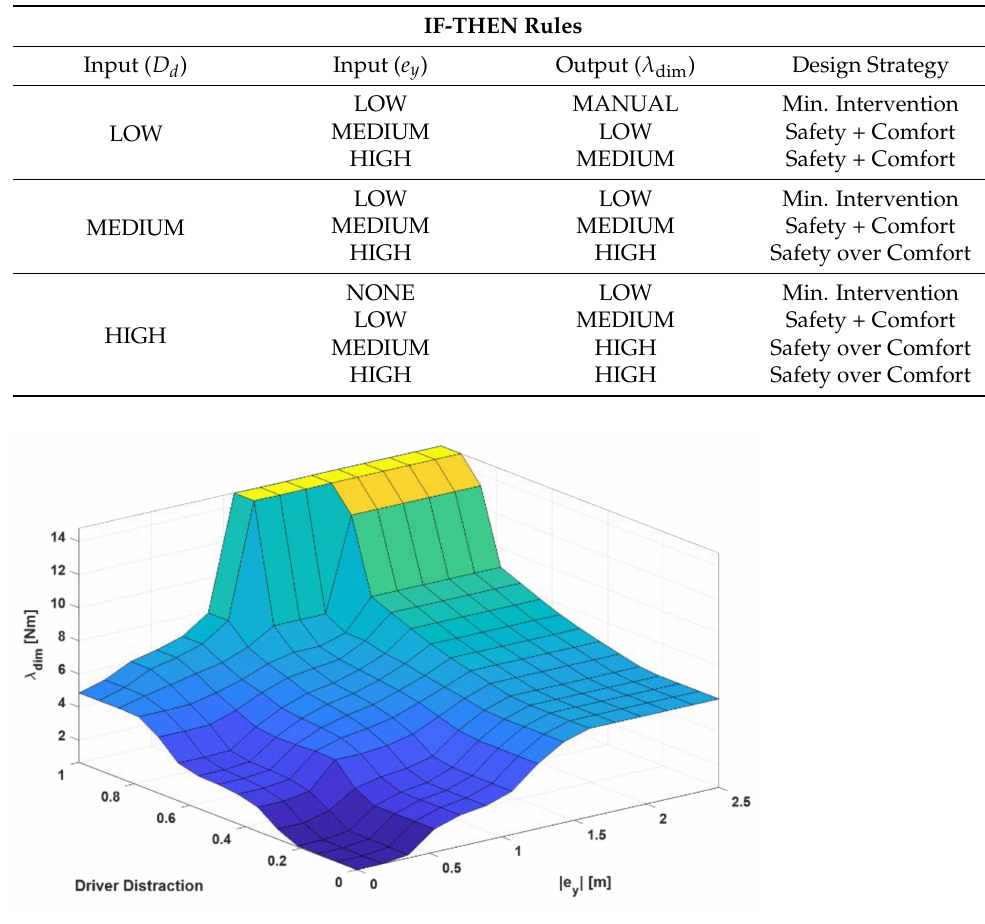
Figure 5. Authority surface calculated by the arbitration module for the distracted driver use